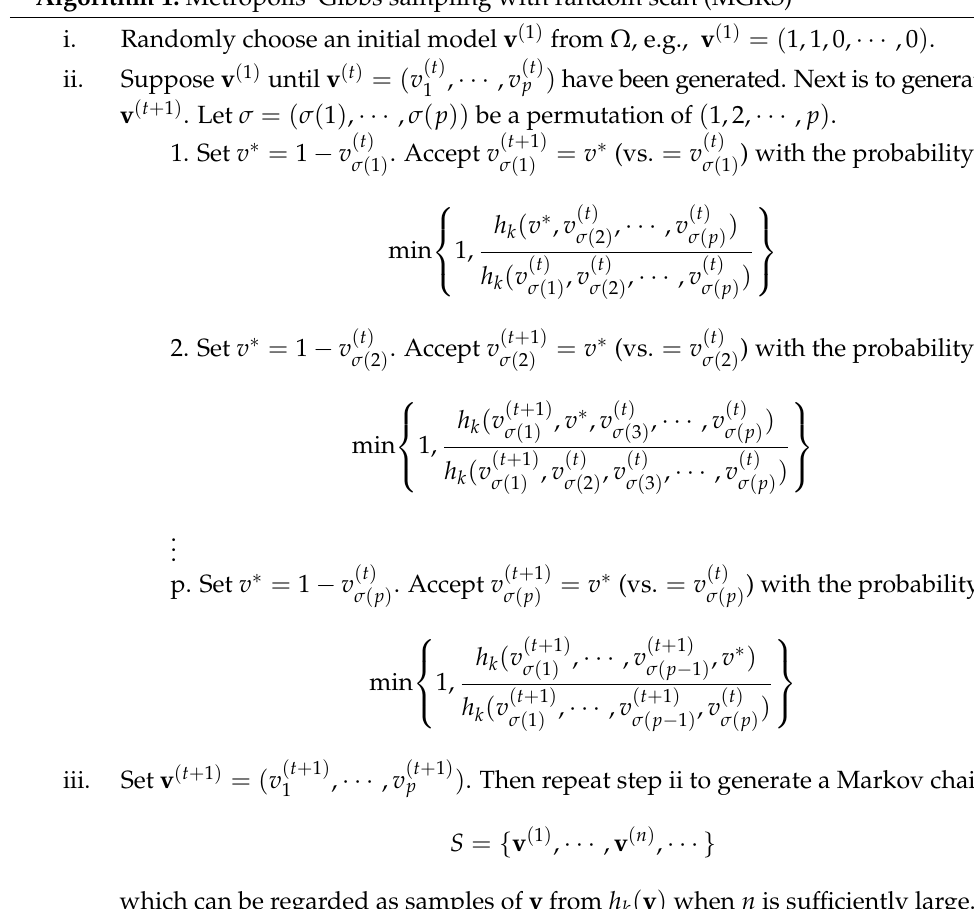
Algorithm 1: Metropolis–Gibbs sampling with random scan